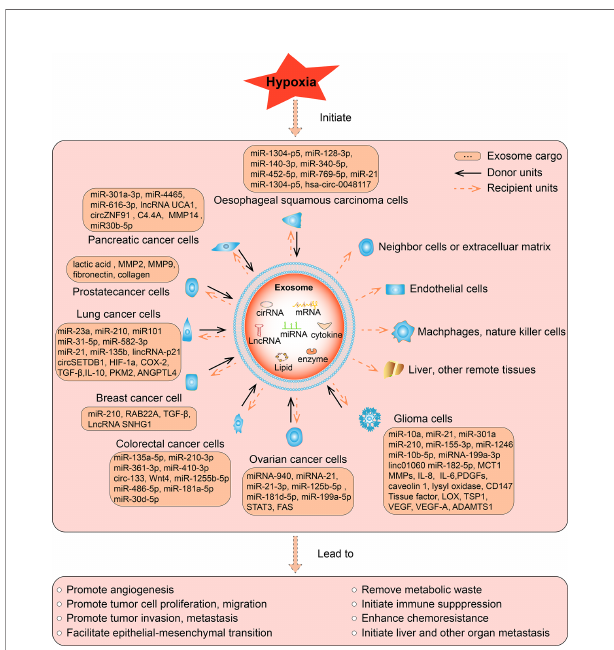
FIGURE 2 | The function of hypoxic exosomes in tumors. In different tumors, hypoxia increased the secretion of exosomes from cancer cells, accompanied by altered expression of its contents, which can be miRNA, lncRNA, cirRNA, mRNA, protein, or lipid. The contents can be upregulated or downregulated in hypoxic exosomes than normoxic exosomes, such contents are brie fl y listed in the square box. As most studies reported, hypoxia induce the upregulation of its contents, such hypoxic exosomes transmit the key messages to recipient units, result in various biological effects, eventually promote the development of tumors. The solid arrows indicate the donor cells that secret the exosomes, the dashed arrows indicate the recipient cells, organs, and tissues that receive the exosomes. Exosomes are secreted by various hypoxic tumor cells in different types of tumors, and they can be uptaken by normoxic tumor cells, neighboring cells or extracellular matrix, endothelial cells, remote organs or tissues in an autocrine, paracrine, or endocrine manner to exert its